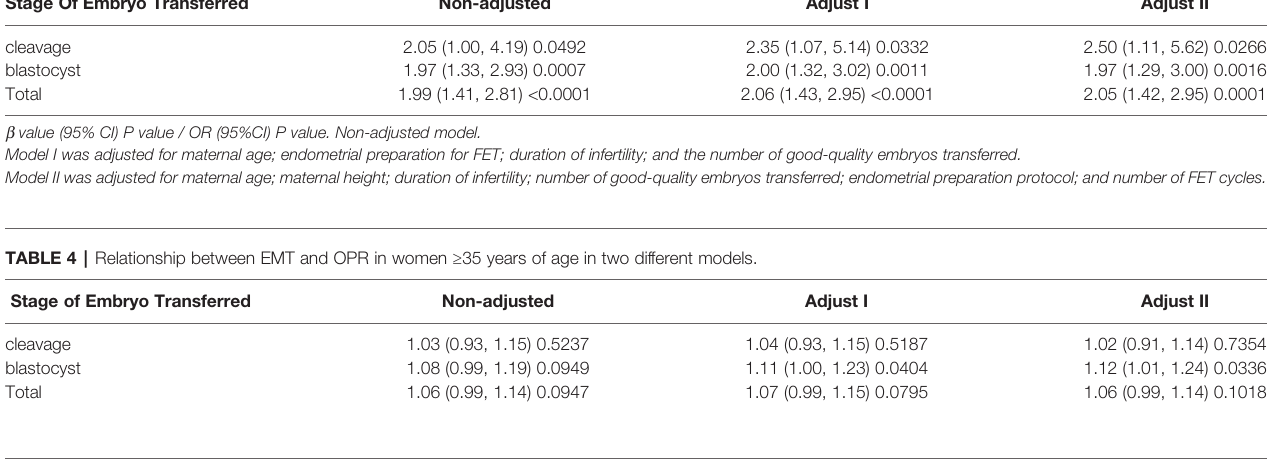
TABLE 3 | Relationship between EMT and OPR in the two different models for women aged < 35 years or with EMT ≤ 8 mm. Stage Of Embryo Transferred